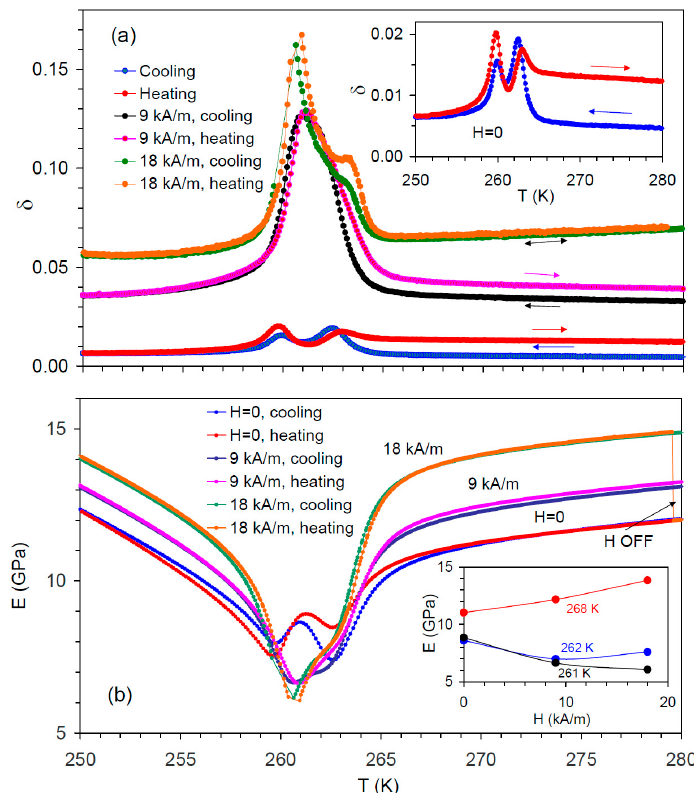
Figure 2. Temperature spectra of ( a ) internal friction, δ , and ( b ) Young’s modulus, E , of a single crystalline Ni 2 MnGa sample during cooling and heating in a demagnetized state, H = 0, and under an applied field of 9 kA/m and 18 kA/m. The inset in ( a ) shows details of the internal friction spectra for the demagnetized state on an expanded scale. The inset in ( b ) shows the field dependences of the Young’s modulus at 268 K, 262 K, and 261 K. The arrow H OFF in ( b ) shows the abrupt drop of the Young’s modulus down to the values of the demagnetized state after switching off magnetic field H = 18 kA/m during the heating scan.